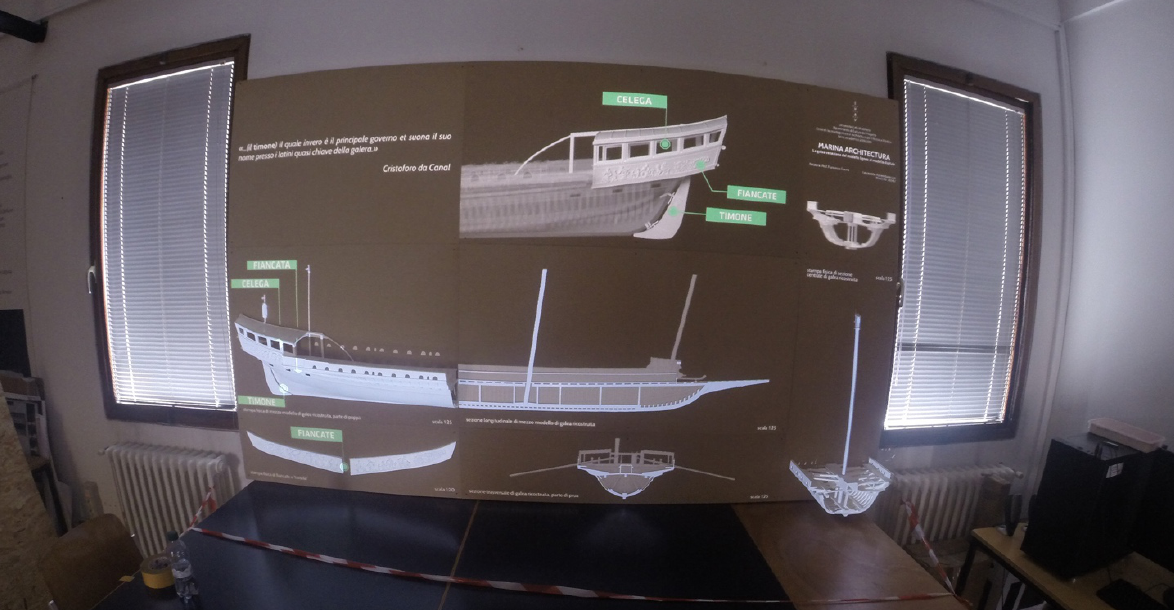
Figure 12. Simulation in the lab of the exhibit